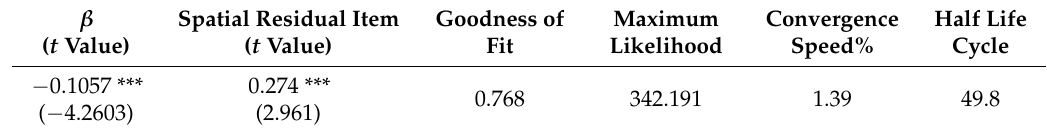
Table 7. Estimation results of the absolute β -convergence SEM model for ITE